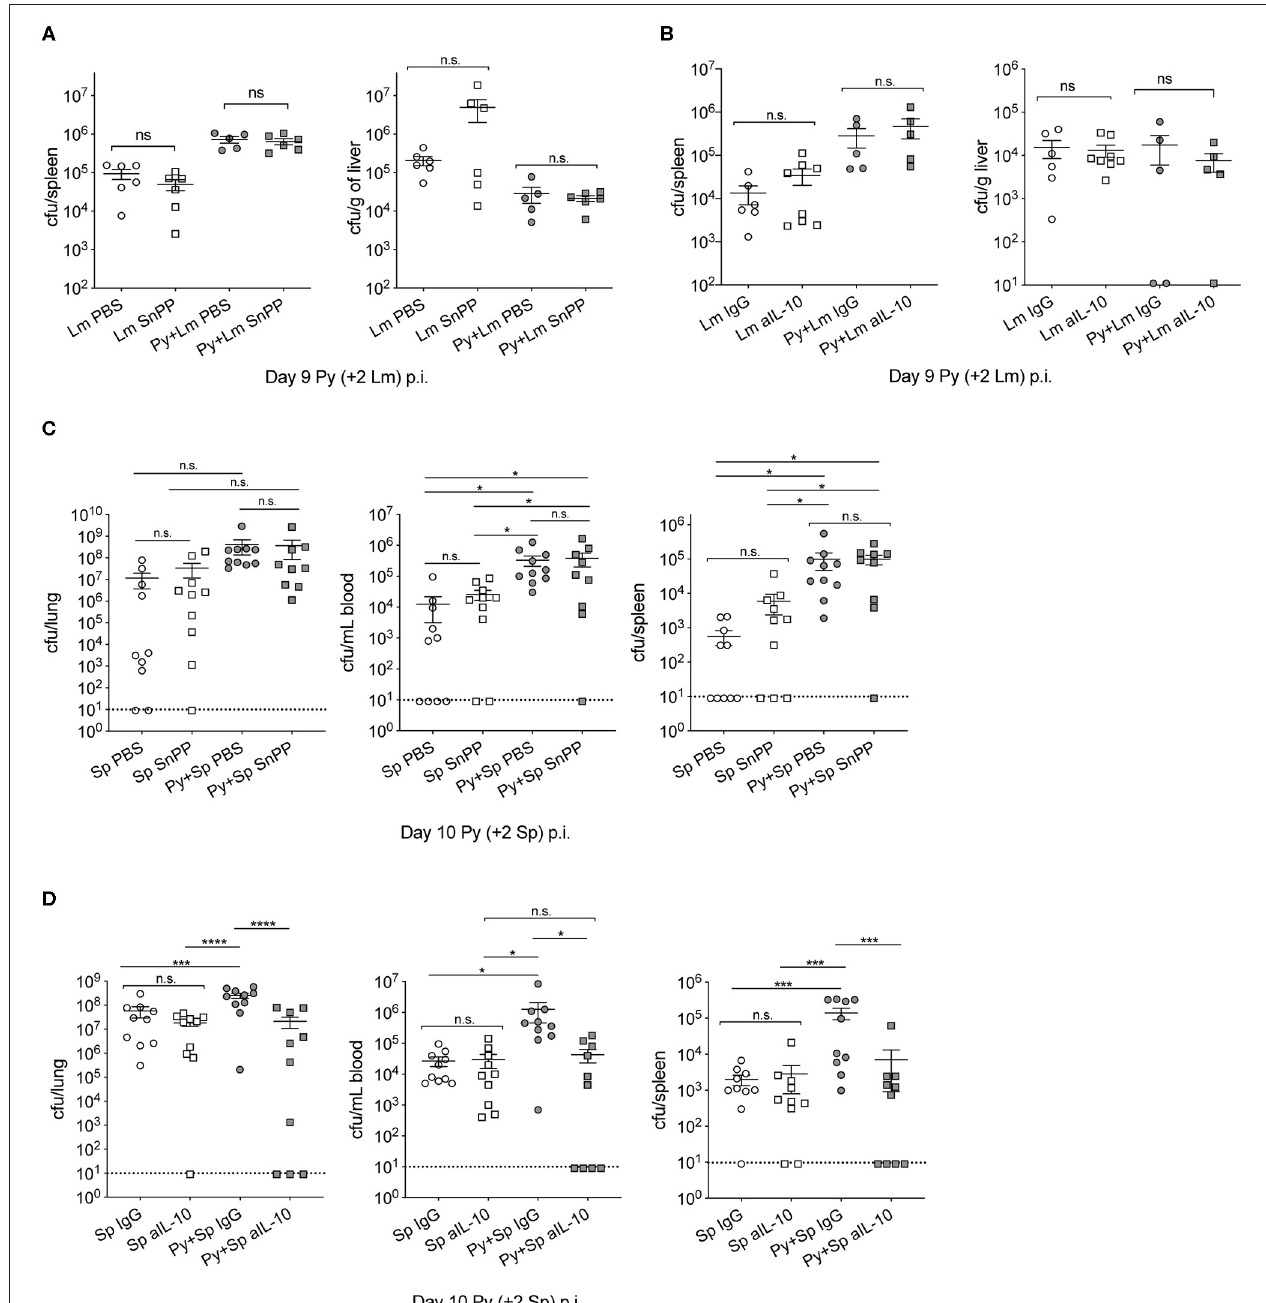
FIGURE 4 | Effect of P. yoelii induced HO-1 and IL-10 on susceptibility to invasive bacterial infection is bacteria-specific. (A,B) C57BL/6N mice were infected with 10 5 Py pRBCs, 7 days later both control and Py-infected mice were infected with 5 × 10 6 CFU Lm. Spleen and liver bacterial burdens were determined day 2-post Lm infection. Mice were treated with tin protoporphyrin IX (Sn PP) or PBS control at 48, 24 and 8h before Lm infection (A) , or α IL-10 antibody or isotype control on days 6, 7, and 8 post Py (B) . Data (mean ± S.E.) are cumulative results from two independent experiments with 3–6 mice per group analyzed with One-Way ANOVA followed by Tukey’s multiple comparisons test. (C,D) C57BL/6N mice were infected with 10 5 Py pRBCs, 8 days later both control and Py-infected mice were infected i.n. with 5 × 10 5 CFU Sp. Lung, spleen, and peripheral blood bacterial burdens were determined day 2-post Sp infection. Mice were treated with tin protoporphyrin IX (Sn PP) or PBS control at 48, 24 and 8h before Sp infection and 24h post Sp infection (C) , or α IL-10 antibody or isotype control on days 6, 7, and 8 post Py (D) . Data (mean ± S.E.) are cumulative results from two independent experiments with five mice per group and analyzed with One-Way ANOVA followed by an uncorrected Fischer‘s LSD test with multiple comparisons, n.s., not significant. * p < 0.05, *** p < 0.001, and **** p < 0.0001.